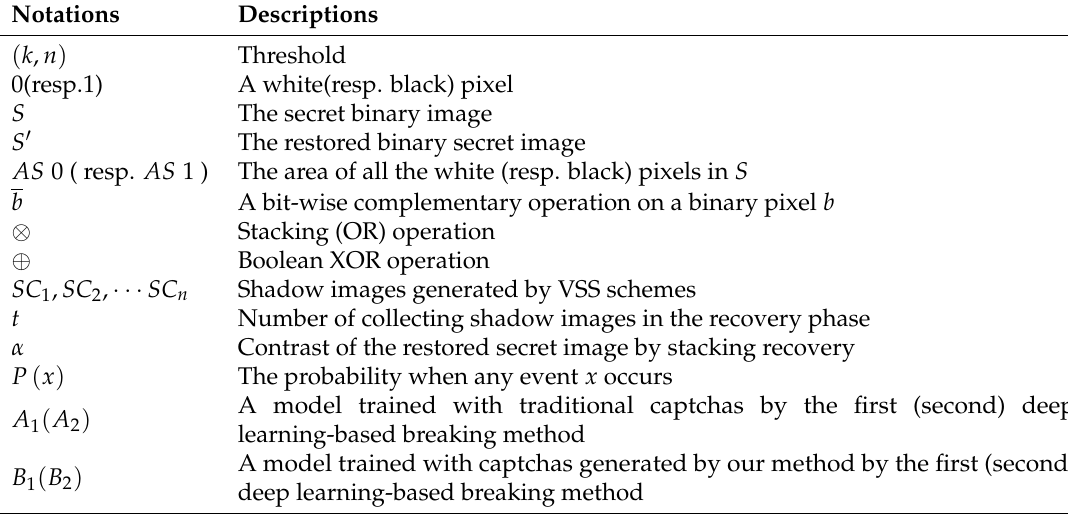
Table 1. The main notations used in this